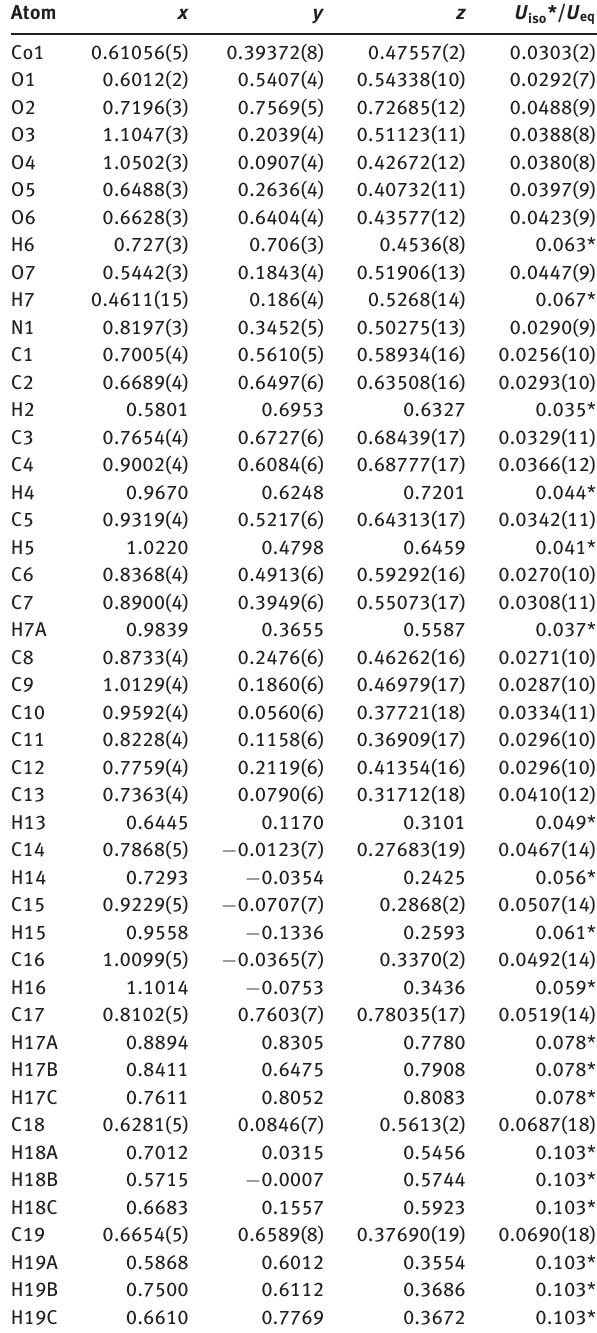
Table 2: Fractional atomic coordinates and isotropic or equivalent isotropic displacement parameters (Å 2